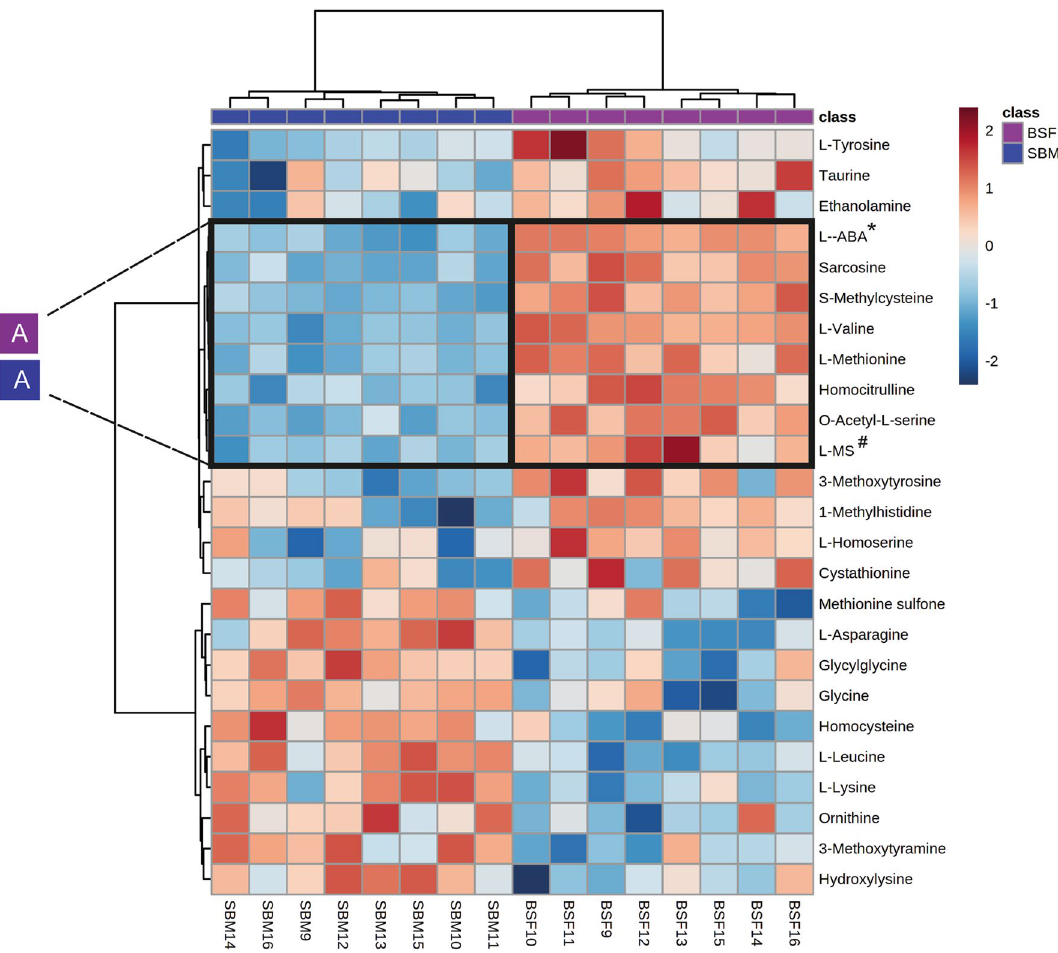
Figure 4. Heat-map of clustering the plasma amine metabolites of pigs in dependence of dietary treatment. SBM: Soybean meal; BSF: Black soldier fly. Values are the relative response ratios of each metabolite of an individual pig per treatment group. Treatment groups comprise of eight pigs. Values are measured in plasma of pigs at d 28 of the experimental period. The heat map graphic distances were measured using Euclidean distances and the clustering algorithm using ward dendrogram. Each colored cell on the map corresponds to a concentration value (normalized to the SBM treatment). The alphabets “A” represent the diets associated cluster formed by set of metabolites (framed in black) having low (shades of blue) or high (shades of red) concentration in the dietary treatments. Here, the colored square corresponds to the respective experimental diets; i.e. navy blue for SBM, and magenta for BSF. “A” indicates amine metabolite clusters referred to the text. *L-ABA: L-Alpha-aminobutyric acid and # L-Methionine